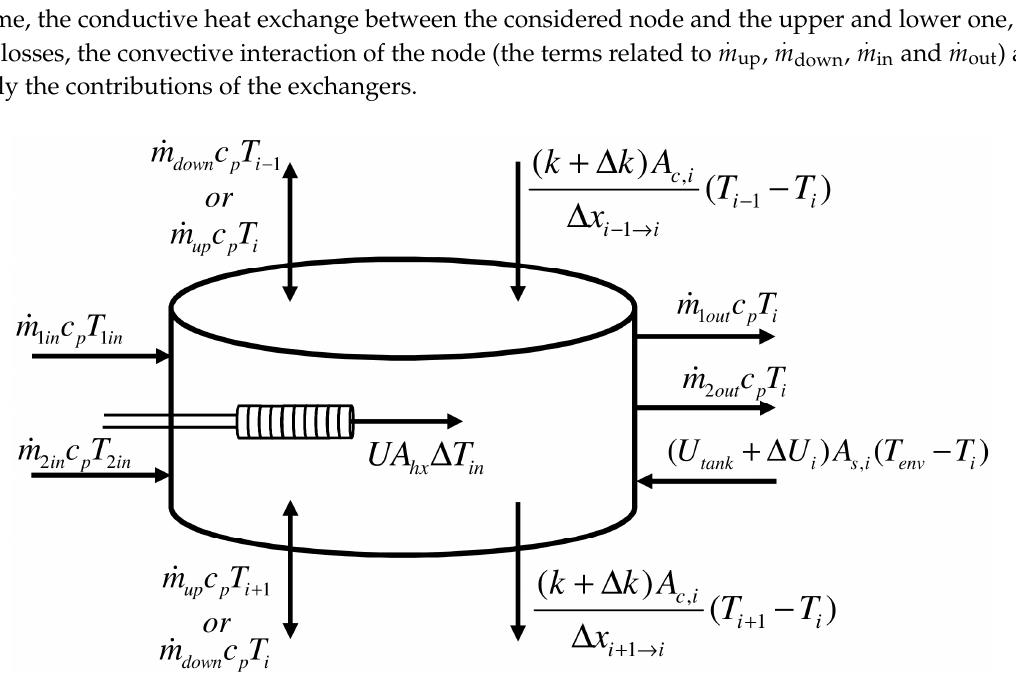
Figure 7. Generic node of a detailed stratified tank storage.